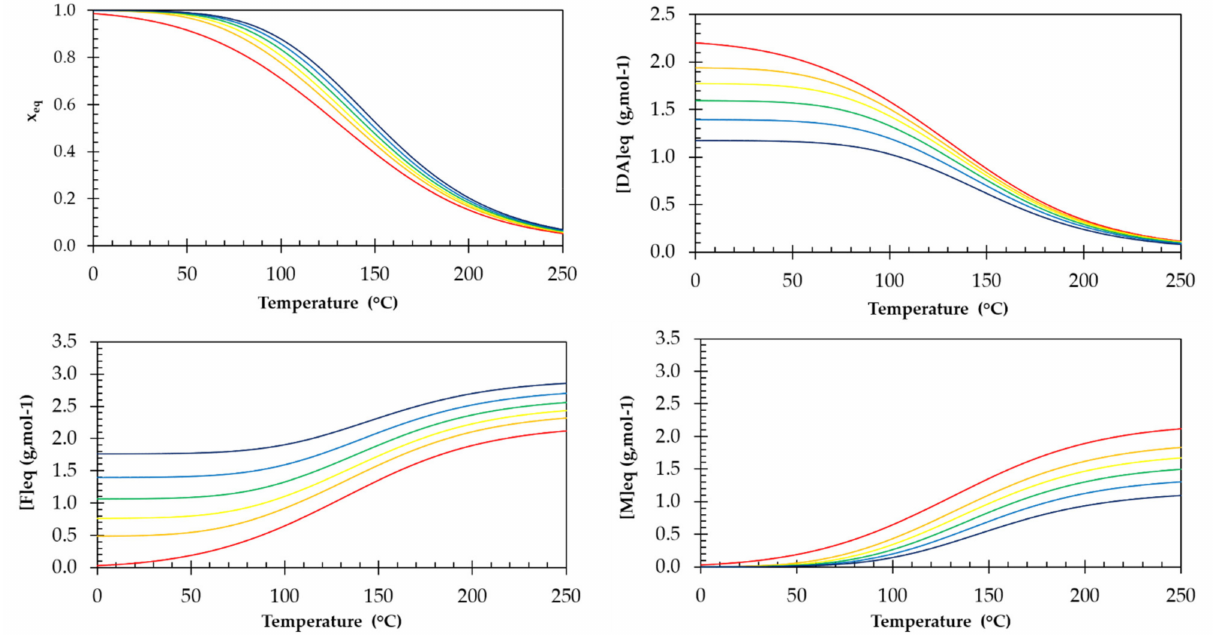
Figure 2. The simulated equilibrium conversion x eq and the equilibrium concentrations [ DA ] eq , [ M ] eq and [ F ] eq as a function of the temperature for the series of six DA networks that differ in stoichiometric ratio: r = 1 (red), r = 0.8 (orange), r = 0.7 (yellow), r = 0.6 (green), r = 0.5 (light blue), and r = 0.4 (dark